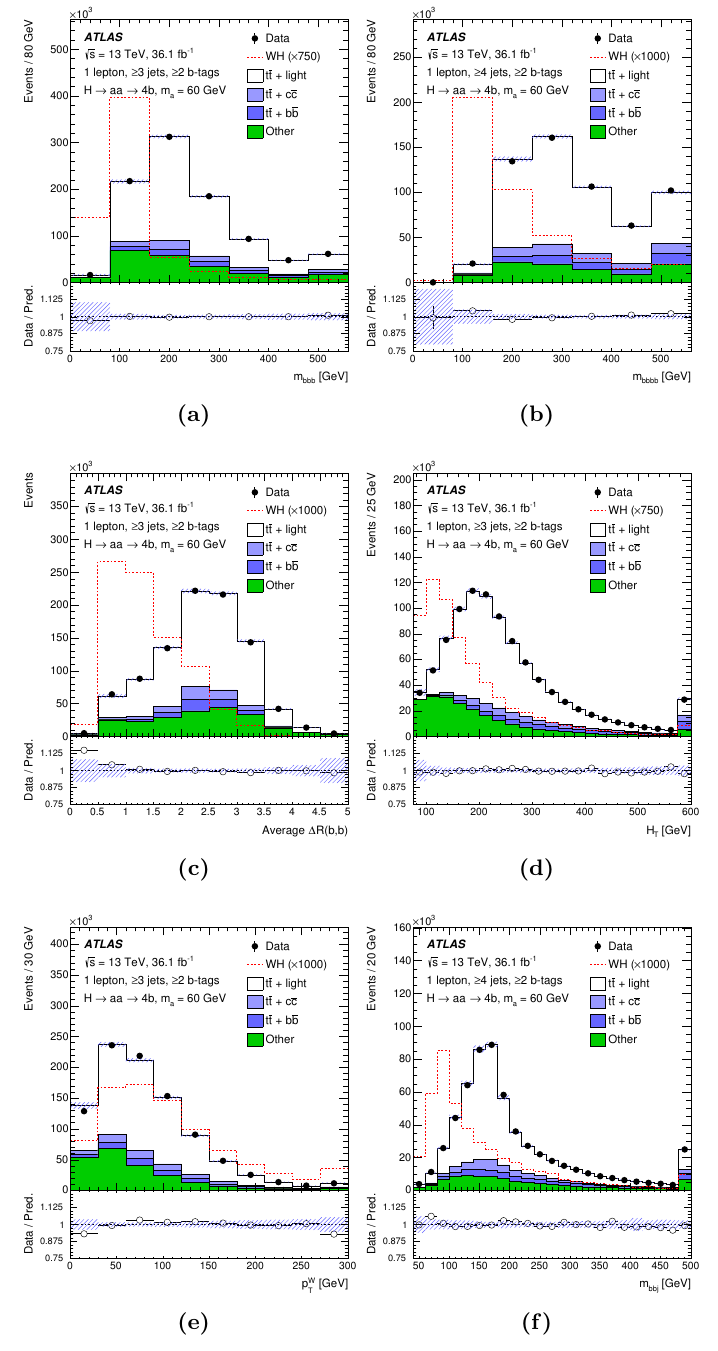
Figure 4. Comparison of data with the post-(cid:12)t background estimates for (a) m bbb , (b) m bbbb , (c) average (cid:1) R ( b , b ), (d) H T , (e) p W and (f) m bbj in the single-lepton sample inclusive in number T of jets and b -tagged jets. Comparisons use events with 3 jets, except when 4 jets are necessary (cid:21) (cid:21) to de(cid:12)ne the variable, in which case events with 4 jets are used. Distributions for the signal (cid:21) model ( WH , H 4 b ), with m a = 60 GeV, normalized to the SM pp aa WH cross-section, ! ! ! assuming ( H 4 b ) = 1 and scaled by a factor as indicated in the (cid:12)gure, are overlaid. The aa B ! ! hashed area represents the total uncertainty in the background. The last bin contains the over(cid:13)ow.